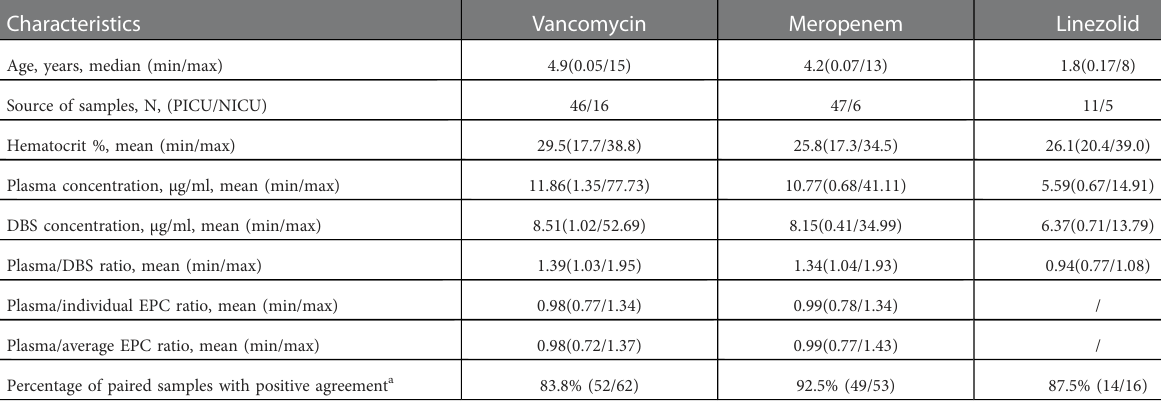
TABLE 5 Characteristics of paired microsamples.